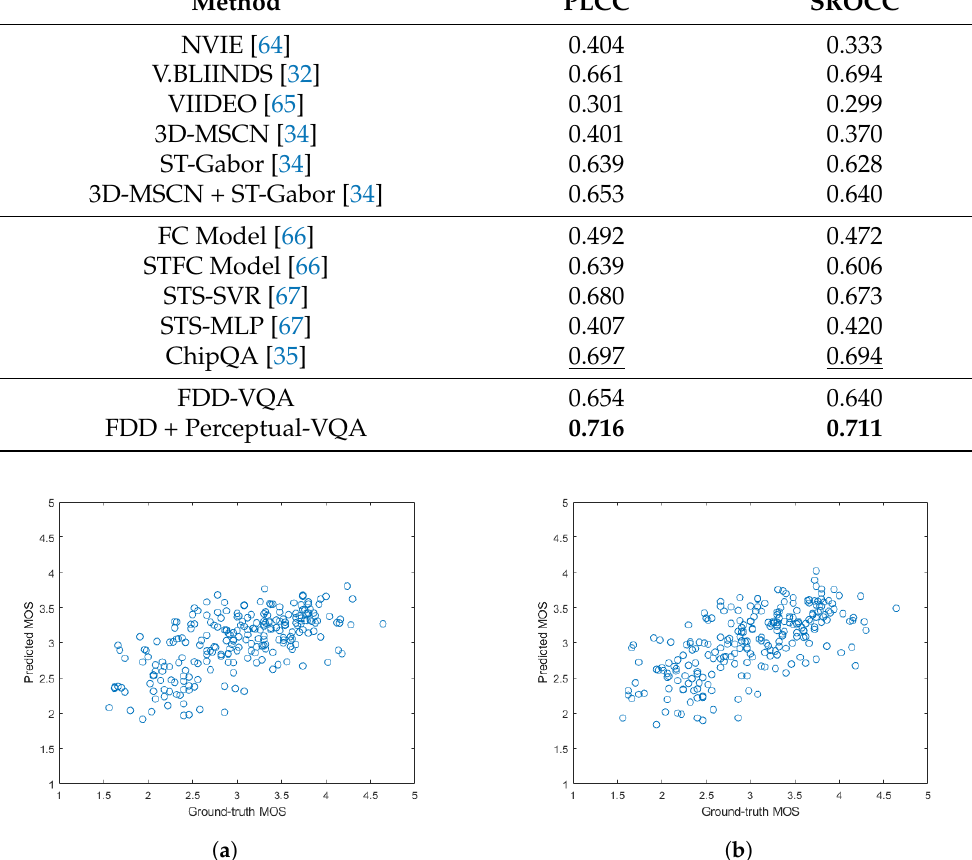
Figure 7. Scatter plots of the ground-truth MOS against the predicted MOS of the proposed methods on the KoNViD-1k [22] test set. ( a ) FDD-VQA. ( b ) FDD + Perceptual-VQA. Table 13. Comparison of FDD-VQA and FDD + Perceptual-VQA to the state-of-the-art on LIVE VQC [23]. Median PLCC and SROCC values were measured over 1000 random train–test splits. The best results are in bold, while the second best results are underlined. We denote by “-” when the data are not